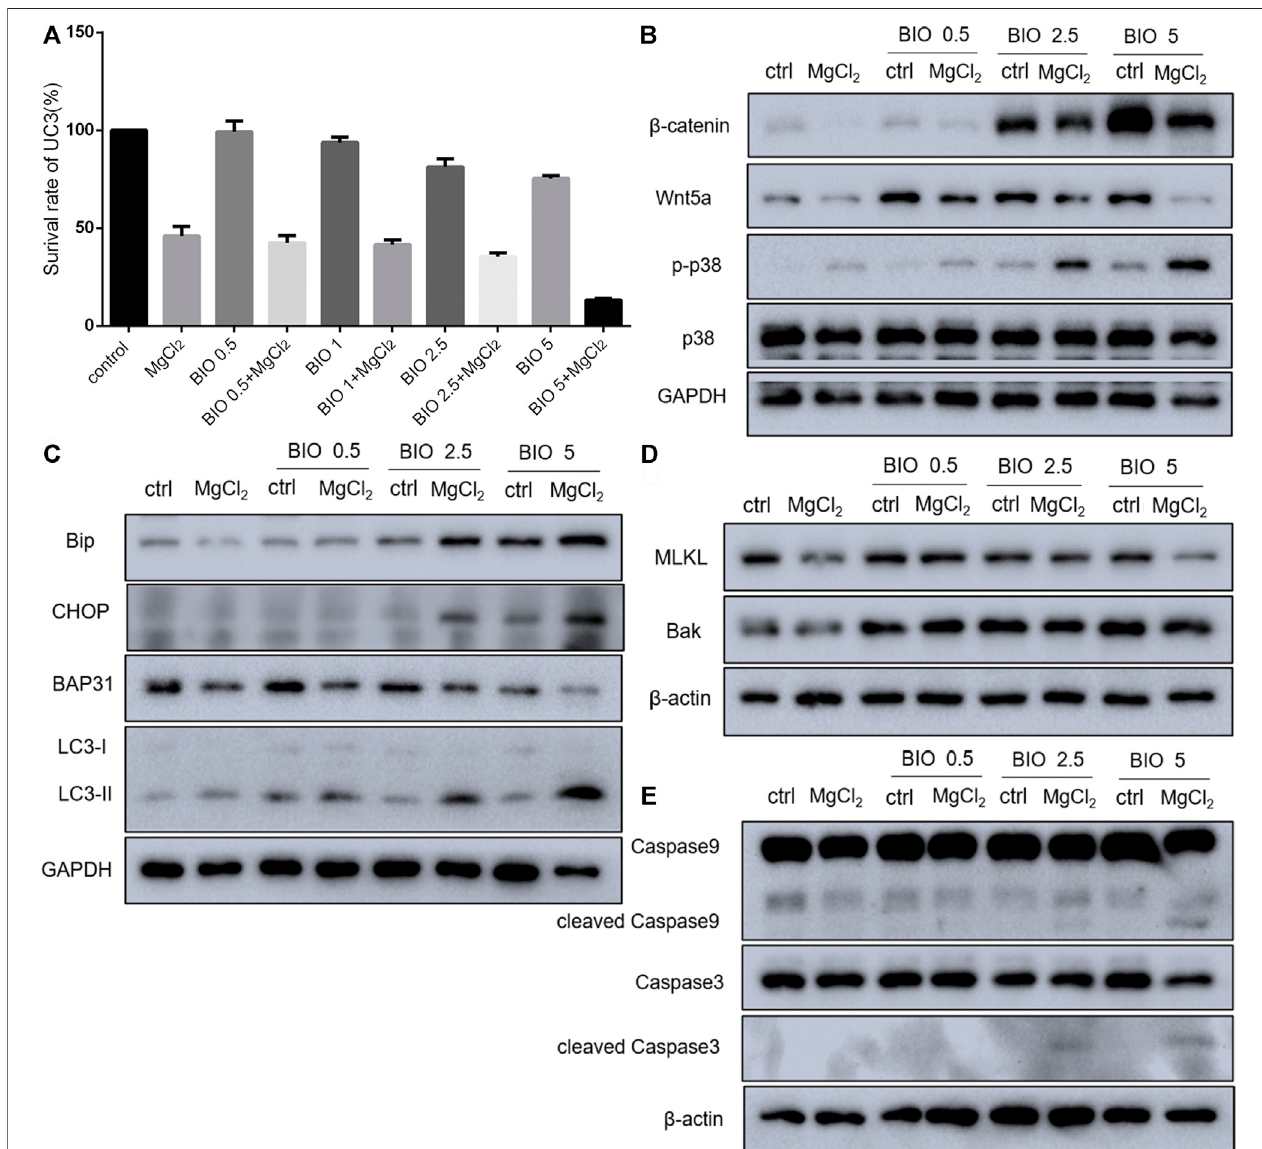
FIGURE 6 | Effect of BIO treatment in MgCl 2 -treated UC3 bladder cancer cells. (A) The cell survival ofUC3 bladder cancer cells treated with MgCl 2 in combination with different concentrations of BIO was examined by the CCK-8 assay. (B – E) Protein expression of genes related to Wnt/ β -catenin signaling components, the MAPK pathway, apoptosis, autophagy, and ER stress in MgCl 2 -and BIO-treated cells as determined by western blot analysis. Densitometry of western blot was showed in Supplementary Figures S11 – S13 .